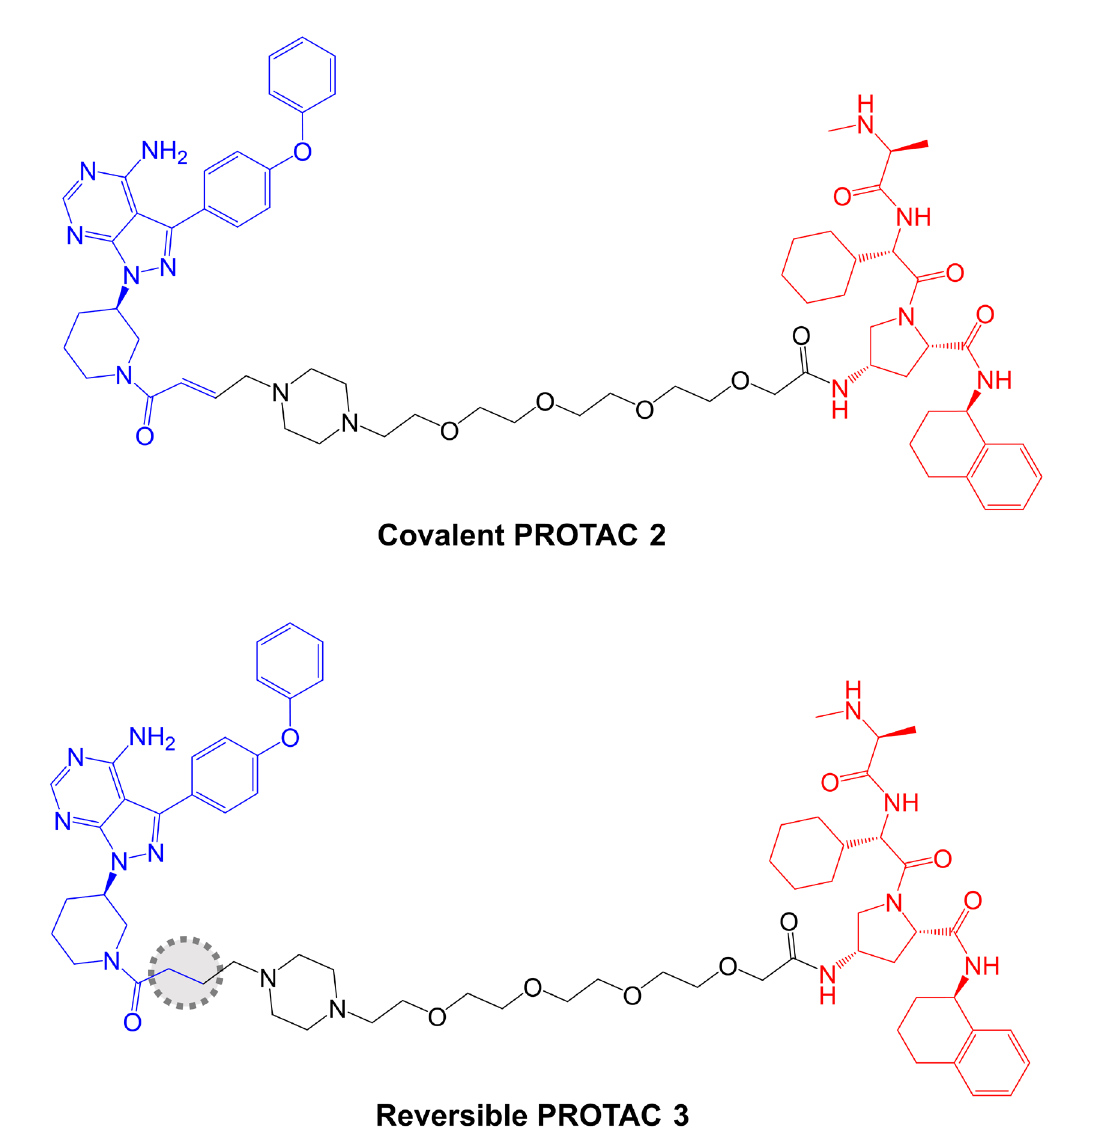
Figure 8. Structures of covalent PROTAC 2 and reversible PROTAC 3. BTK-inhibiting warheads derived from ibrutinib are colored blue and IAP-targeting moieties are colored red [ 95] . The difference in the structure of the reversible PROTAC 3 compared to covalent PROTAC 2 is highlighted by a dotted